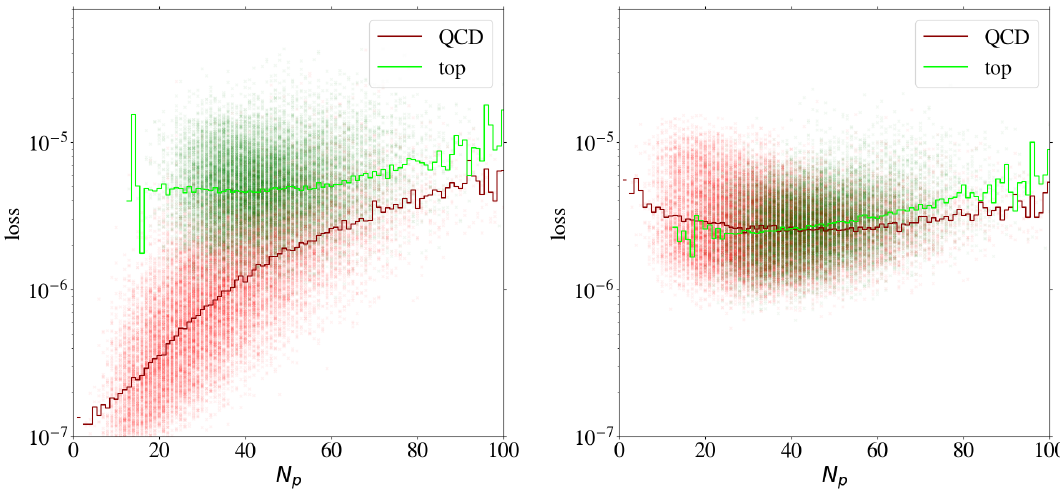
Figure 14 . Same as figure 6 but for KMSE instead of MSE loss (the R 0 -remapping is